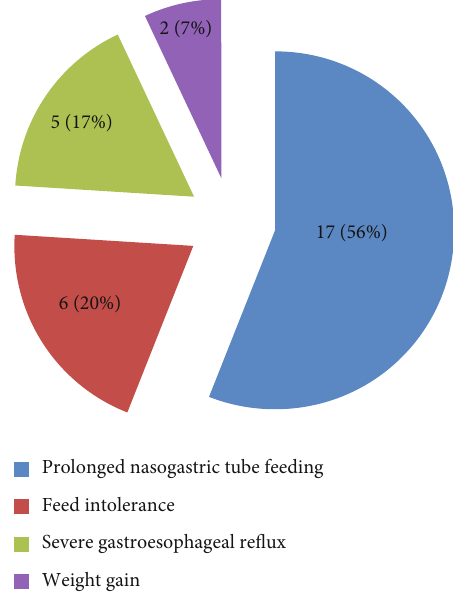
Figure 3: Reason for referral for gastrostomy tube insertion.